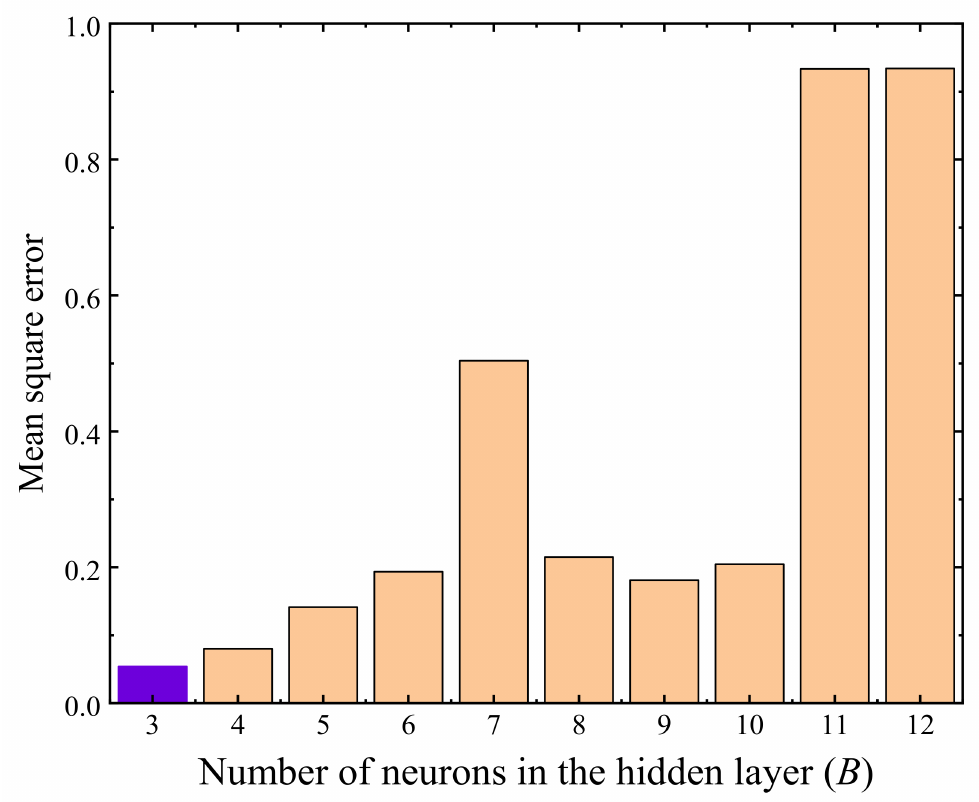
Figure 8. Mean square error with different B values (regarding the σ cri